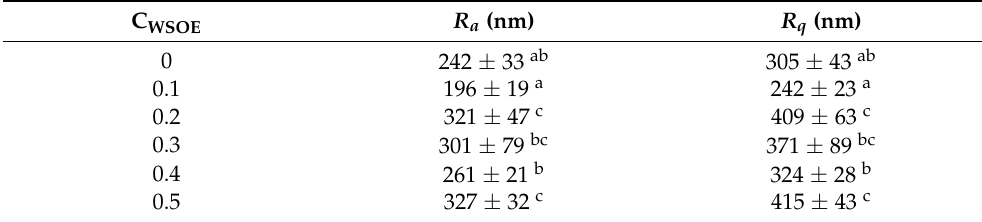
Different lowercase letters in the same column indicate significant differences ( p < 0.05) by Duncan’s multiple range test.